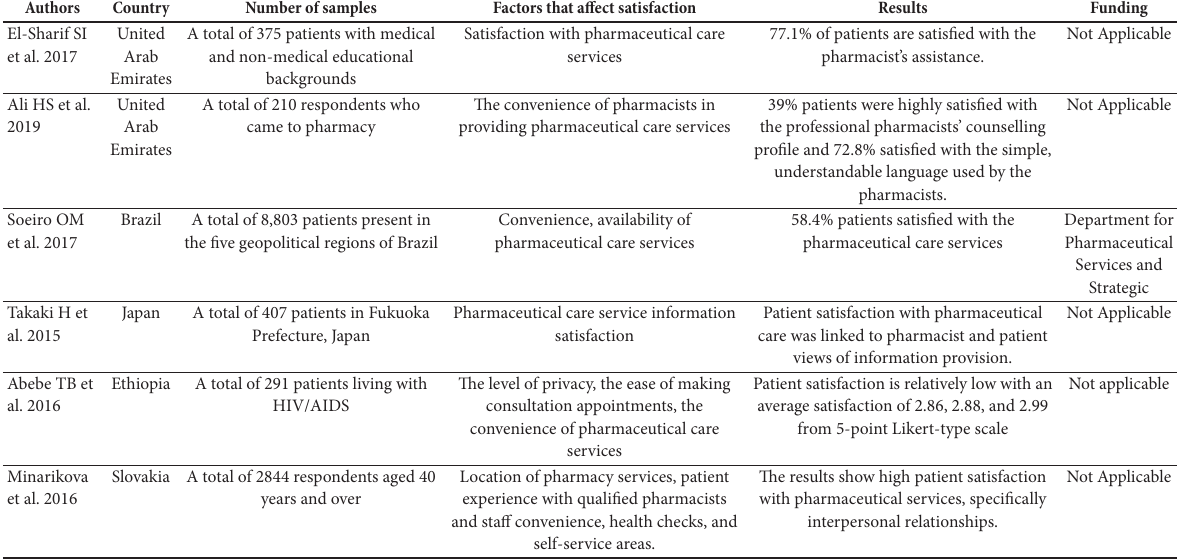
Table 5. Patient satisfaction with pharmaceutical care